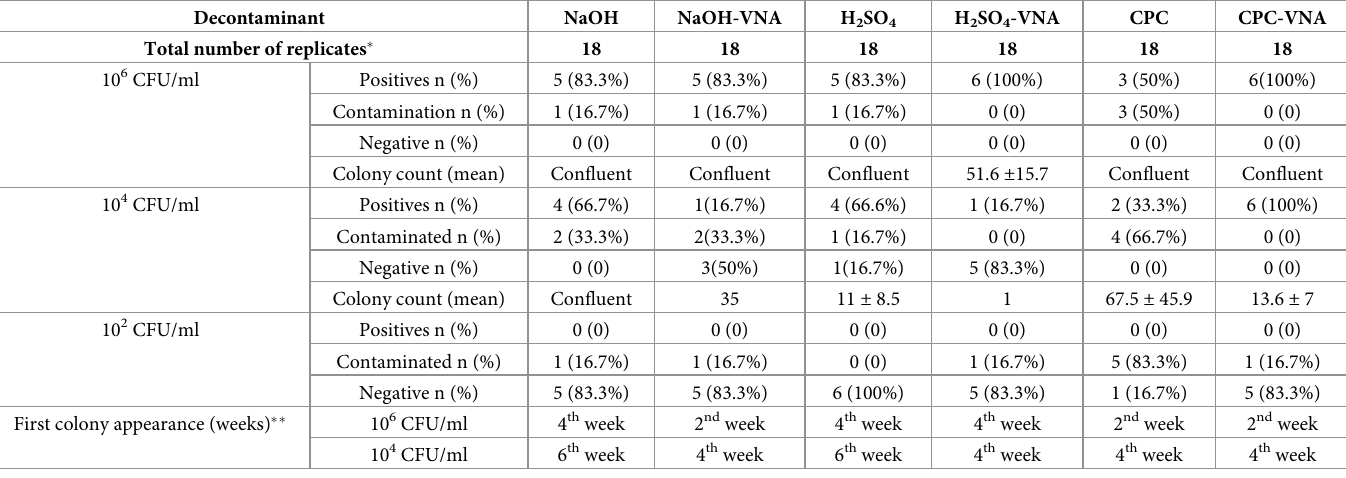
Table 2. Mean colonies count and number of weeks for first appearance of growth of M . avium from spiked samples decontaminated using 6 procedures. Decontaminant